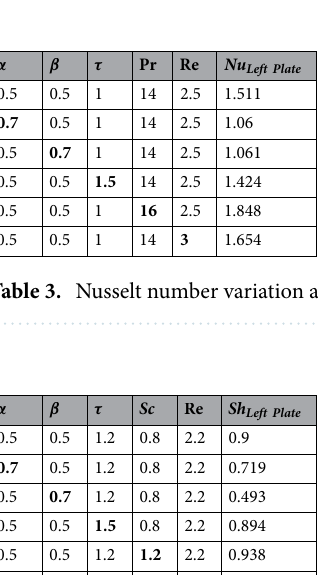
Table 2. The skin friction of couple stress fluid at right plate: